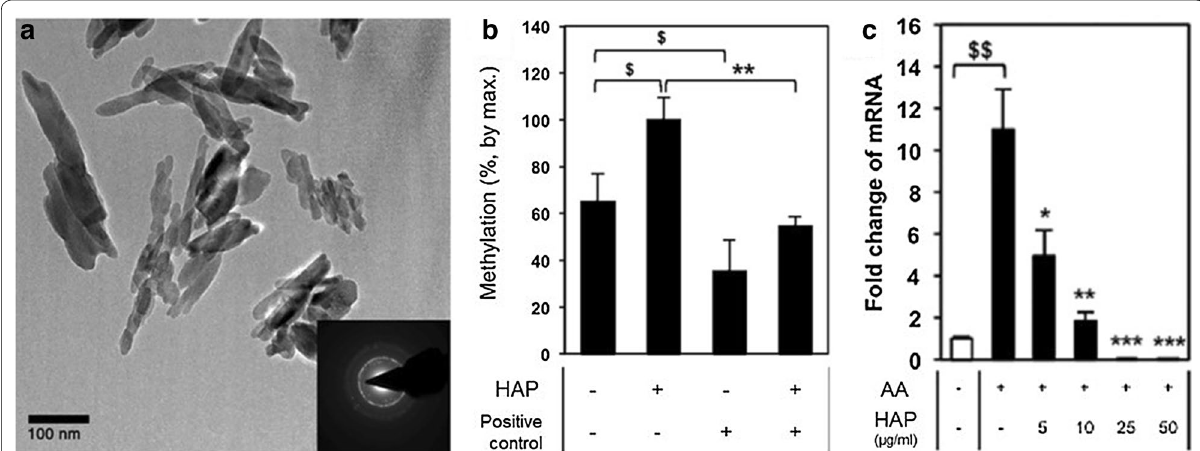
Fig. 5 a TEM image of synthesized HAPs, b methylation ratio of BMSC, and c suppression of ALP-related mRNAs according to the number of injected HAPs. The inset of TEM image is electron diffraction patterns by TEM (Reproduced with permission